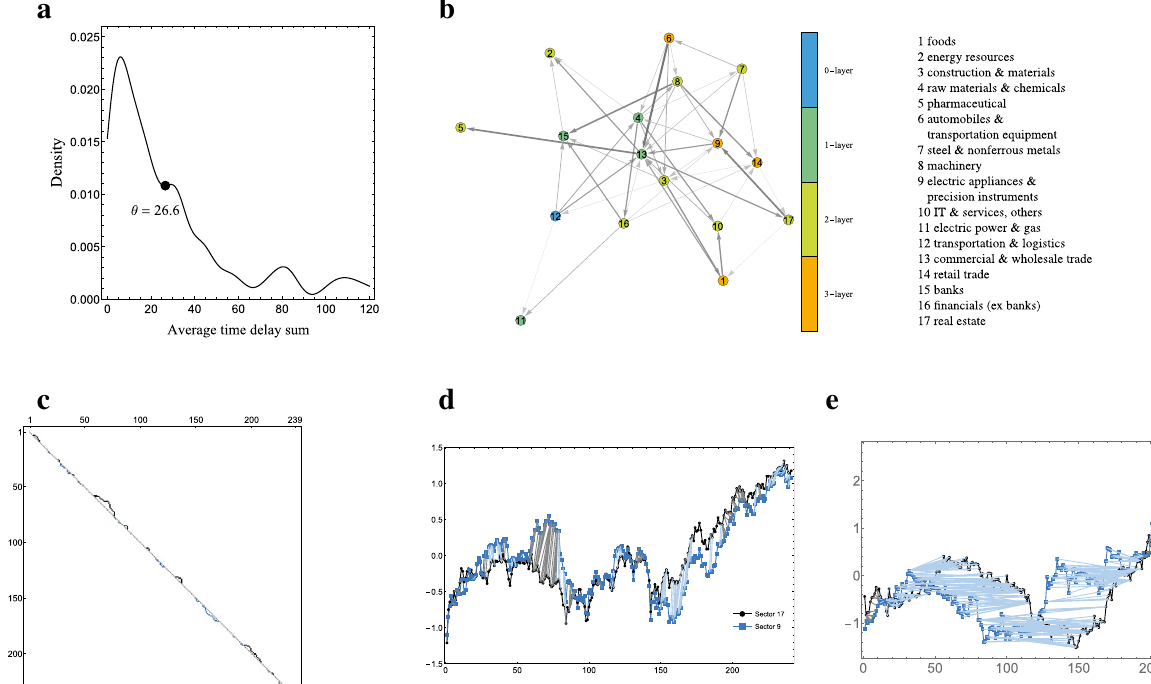
Figure 4. Results for stock market datasets. ( a ) Probability density of average time delay sum estimated by kernel density estimation for stock market datasets. We used Gaussian kernel with a bandwidth with the parameter β = 0.25 . The black circle ( θ = 26.6 ) indicates a threshold value adopted by our method. ( b ) The estimated stock price propagation graph by the proposed method. Each vertex is labeled by its representing sector number. Each vertex’s color indicates its belonging layer: blue, green, yellow and orange vertices belong to V ˆ E 0 , V ˆ E 1 , V ˆ E 2 , and V ˆ E 3 , respectively. The thickness of an edge shows the size of the average time delay; the thicker the edge is, the longer the delay is. ( c ) The minimum cost alignment path between s 9 and s 17 in the dynamic programming table for the minimum cost alignment. The diagonal positions correspond to no delay, and above and below diagonal positions correspond to the statuses of delayed s 9 and s 17 , respectively. ( d ) Line graph of time series s ′ 9 and s ′ 17 with their matched positions in the minimum cost alignment. The average time delay sum of s 9 from s 17 is 22.0. The horizontal axis is time, and the vertical axis is standardized stock price. Gray and light blue lines between s ′ 9 and s ′ 17 indicate estimated correspondences between the stock price derivative time series s 9 and s 17 in the minimum cost alignment. The gray (light blue) lines indicate that the sector 9 (sector 17) follows the sector 17 (sector 9). ( e ) The standardized sequences of the opening price for NAGAWA (black) and KYOKUTO BOEKI KAISHA (blue). Lines between them indicate their corresponding positions. The horizontal axis is time, and the vertical axis is standardized stock price. NAGAWA looks following KYOKUTO BOEKI KAISHA with large time delay during time period between 60 and